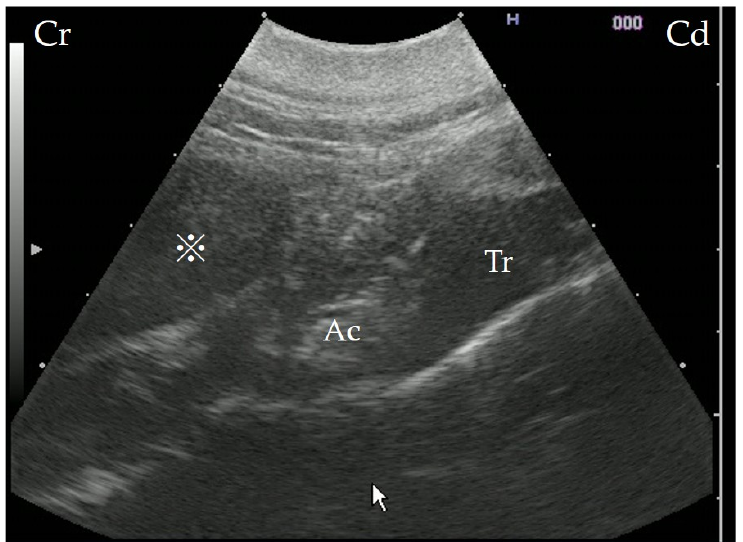
Figure 2. Ultrasonography showing the retropharyngeal mass. The scan was performed from the left side of the cow, with the probe in a transverse position; the trachea and epiglottic cartilage present as landmarks. A mass can be identified on the dorsal surface of the arytenoid cartilage. Cr: cranial; Cd: caudal; Ac: arytenoid cartilage; Tr: trachea area; ※ : mass.